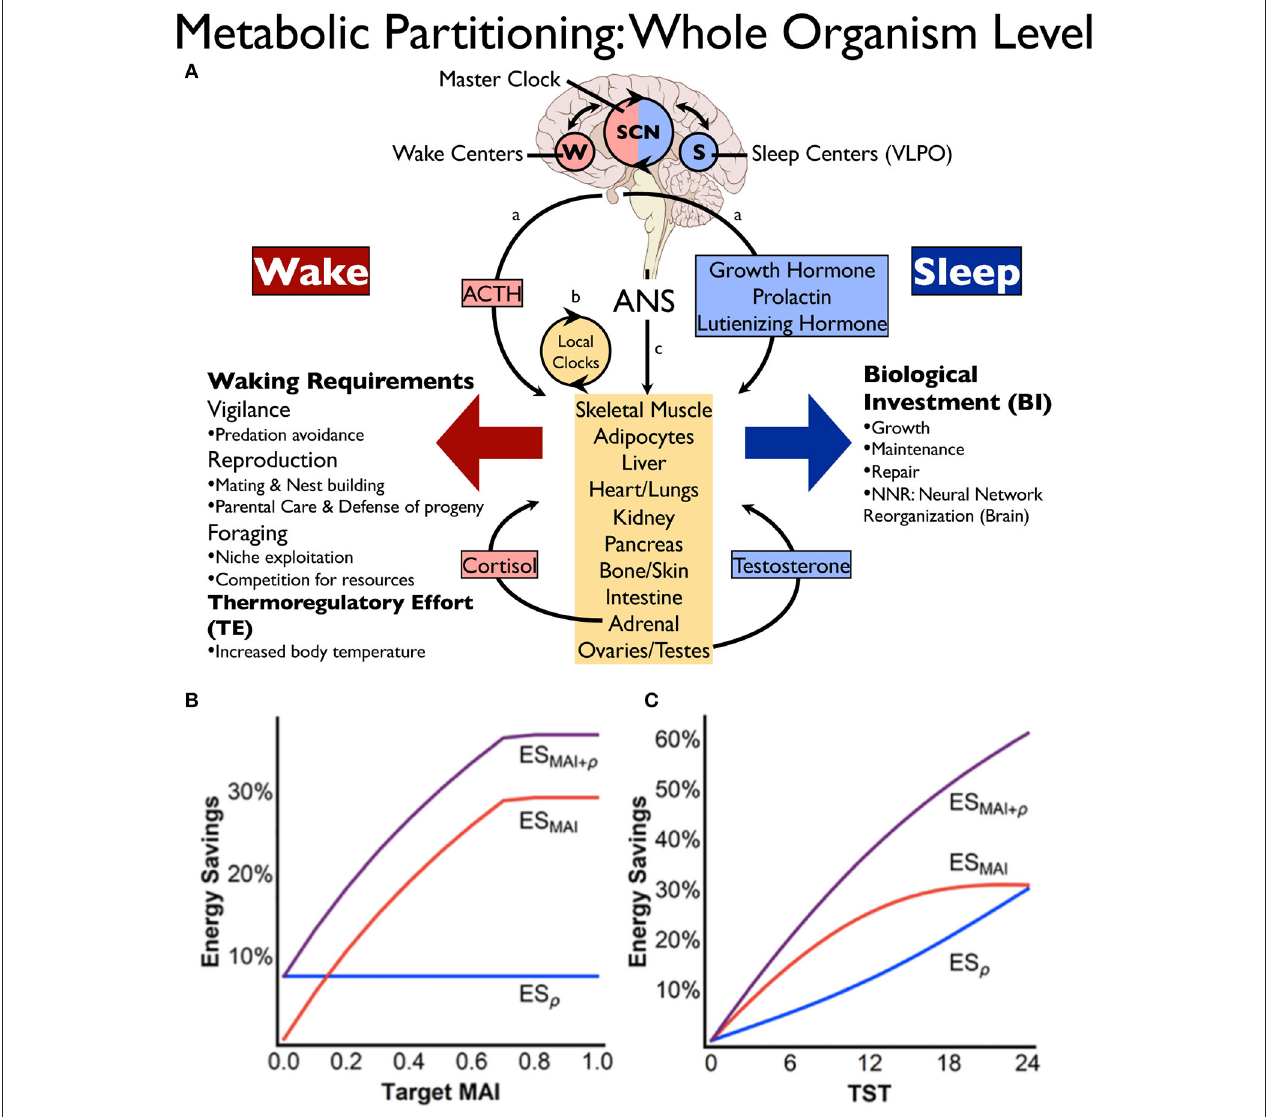
FIGURE 1 | Energy conservation through state-dependent (sleep-wake) metabolic partitioning. (A) Control of resource allocations involves both brain and periphery. Within the brain, sleep or wakefulness is expressed based on the interplay between sleep (S) and wake (W) promoting centers, the timing of which is modulated by the suprachiasmatic nucleus (SCN). Wake predominant (red) or sleep predominant (blue) processes in the periphery are synchronized with behavioral state (brain) through: (a), hormonal control, (b) local autonomous circadian clocks in peripheral tissues, and (c) direct descending autonomic nervous system (ANS) innervation from brain to periphery [reprinted with permission from Schmidt (37)]. (B,C) Energy savings calculations based on mathematical modeling showing the potential impact of metabolic partitioning (B) or sleep quota (C) on energy savings derived from sleep-wake cycling. In (B) , metabolic partitioning, represented by the metabolic allocation index (MAI), can be varied in the model from 0 to 1 (0 indicating all biological processes are equally performed in both states, whereas MAI = 1 signifies that all functions performed during wake are different from sleep). Target MAI is varied in the figure while holding metabolic rate reduction during sleep ( ρ ) and total sleep time (TST) constant. Note in the figure that an 8h sleep quota and a metabolic rate reduction during sleep of 30% ( ρ = 0.3) constrain maximum MAI to ∼ 0.7. In (C) , TST is varied while holding target MAI = 0.4 and ρ = 0.3. Blue line is energy savings from metabolic rate reduction (ES ρ ), red line is saving from MAI (ES MAI ), and purple line is overall energy savings (ES MAI + ρ ). Reprinted from Schmidt et al.